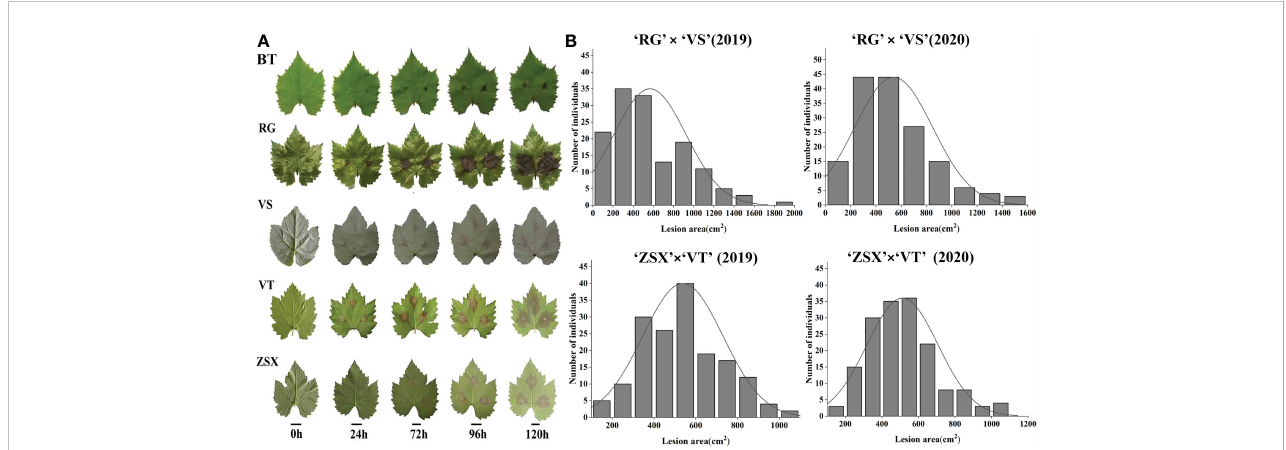
FIGURE 1 Grapevine gray mold resistance identi fi cation of fi ve grape cultivars and two hybrid populations. (A) Gray mold lesion area identi fi cation of fi ve grape cultivars. ‘ BT, ’ ‘ RG, ’ ‘ VS, ’ ‘ ZSX, ’ and ‘ VT ’ represent grape cultivars ‘ Beta, ’ ‘ Red Globe, ’ ‘ Venus seedless, ’ ‘ Zhuosexiang, ’ and ’ Victoria, ’ respectively. (B) Gray mold lesion area distribution of two hybrid populations in 2019 and